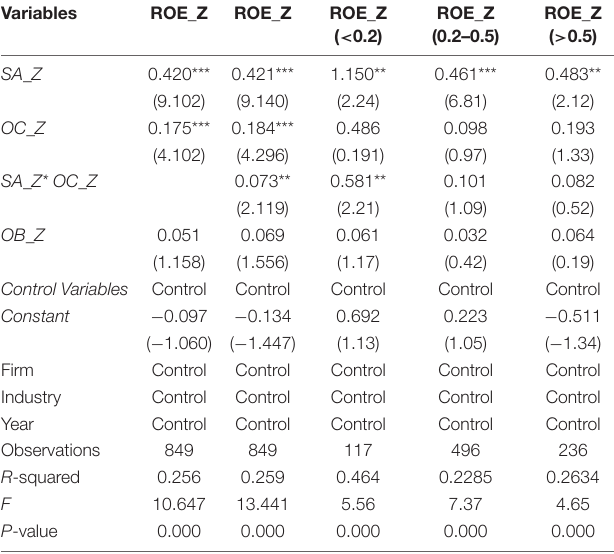
TABLE 8 | Regulatory effect test results – based on multiple regression